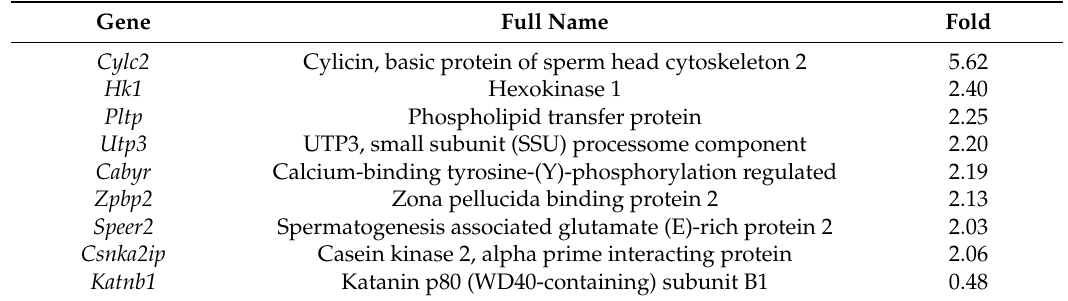
Table 1. Expressional changes in the spermatogenesis-related genes of the D -gal-injected mice.